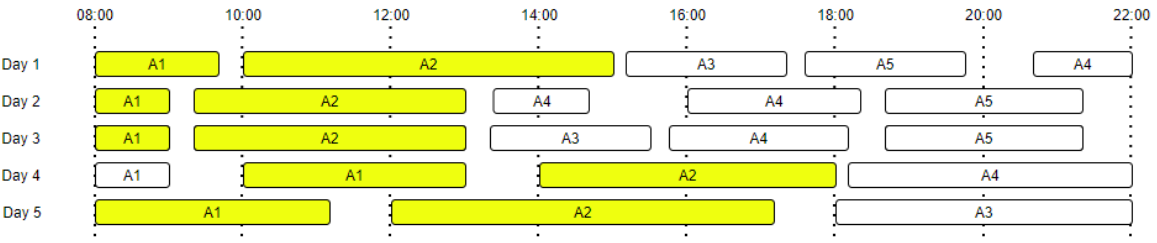
Figure 1. Daily activities and transition probabilities ( 𝐴 (cid:2869) to 𝐴 (cid:2870) transitions are marked with yel- low).